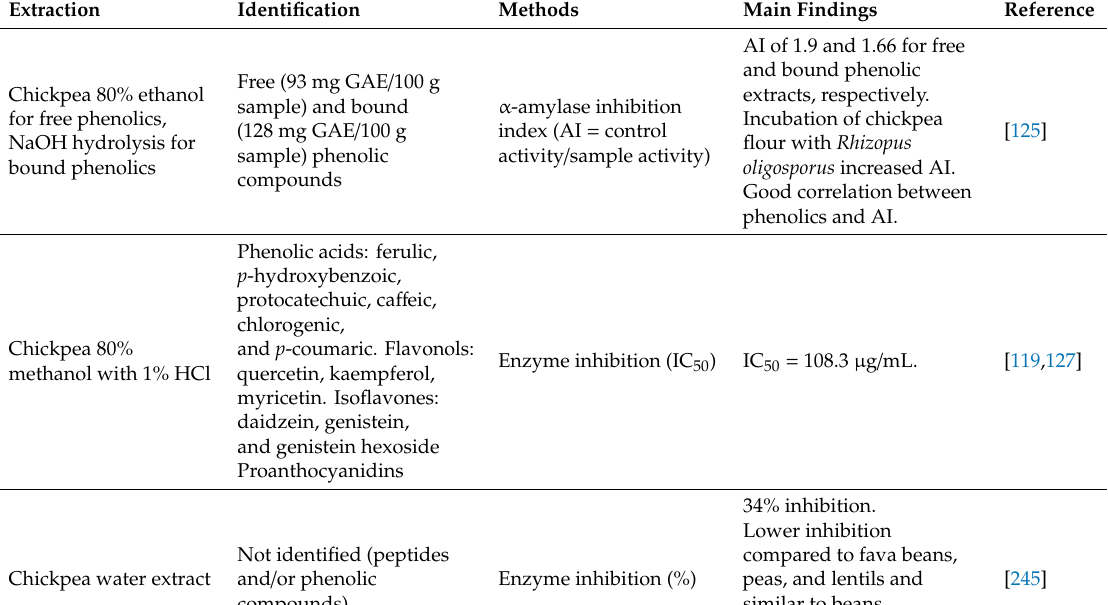
Table 6. Inhibition of α -amylase by soybean and chickpea phenolic